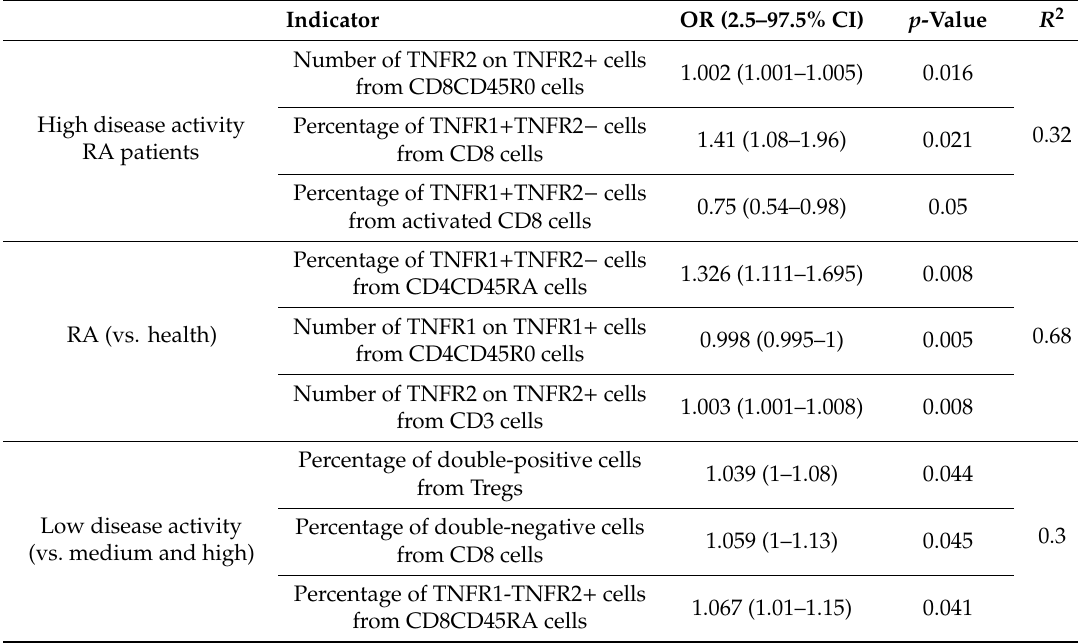
Table 3. Multivariable logistic regression